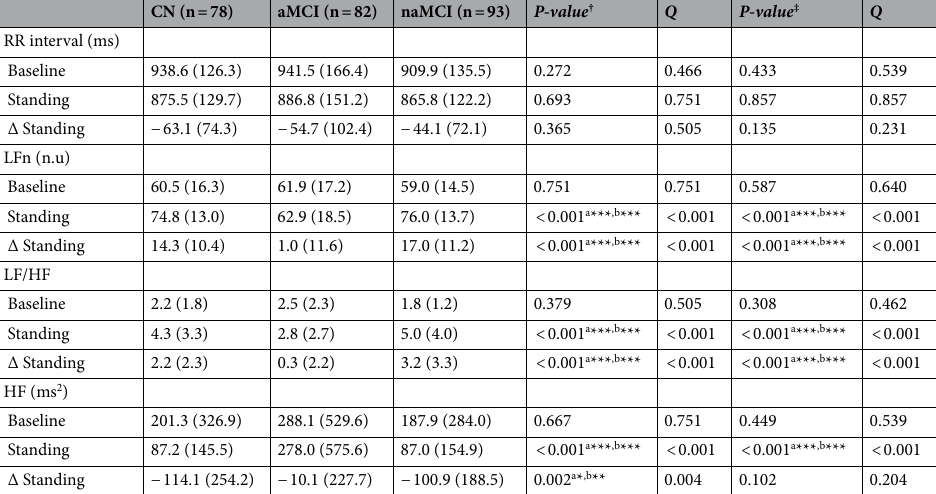
Table 4. Heart rate variability in the study groups. HRV indices expressed as mean (standard deviation). Statistical analyses performed on log 10 - transformed values except for Δ HF standing (untransformed). CN, cognitively normal (controls); aMCI, amnestic mild cognitive impairment; naMCI, non-amnestic mild cognitive impairment; n.u, normalised units; LFn, low frequency power (normalised); LF/HF, ratio of low frequency power (LF) to high frequency power (HF); Δ standing, standing HRV index—baseline HRV index. † ANOVA for all HRV indices except Δ HF standing (Kruskall-Wallis test). ‡ ANCOVA for all HRV indices except Δ HF standing (non parametric regression). All post-hoc pairwise comparisons performed with Bonferroni correction. Q indicates P -values corrected for multiple testing with the Benjamini– Hochberg procedure with a 5% False Discovery Rate (FDR). a Significant difference between aMCI and naMCI, b Significant difference between aMCI and CN, *** P ≤ 0.001, ** P < 0.01, * P < 0.05.